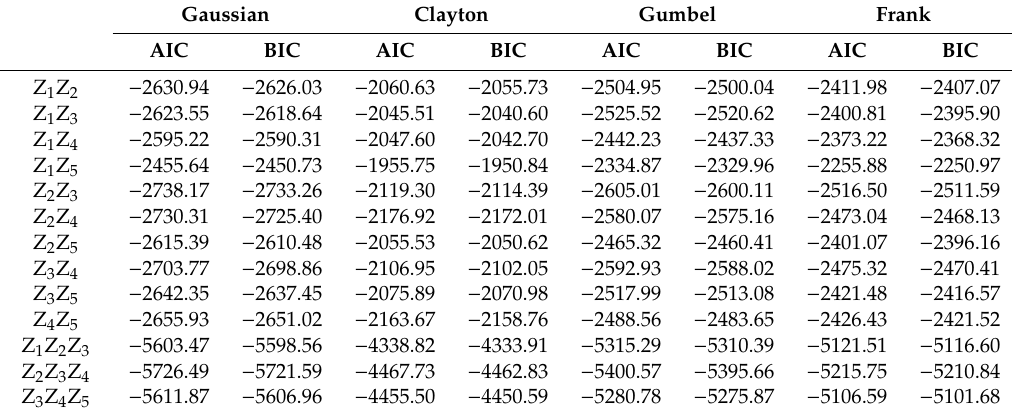
Table 4. Akaike information criterion (AIC) and Bayesian information criterion (BIC) values of candidate copula functions.